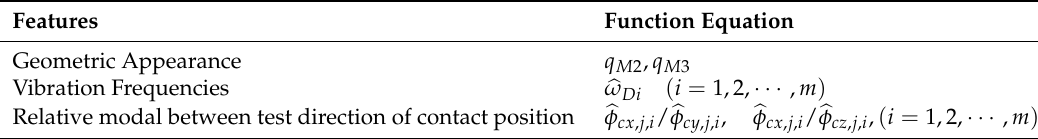
Table 4. The features used for the identification of collision direction.